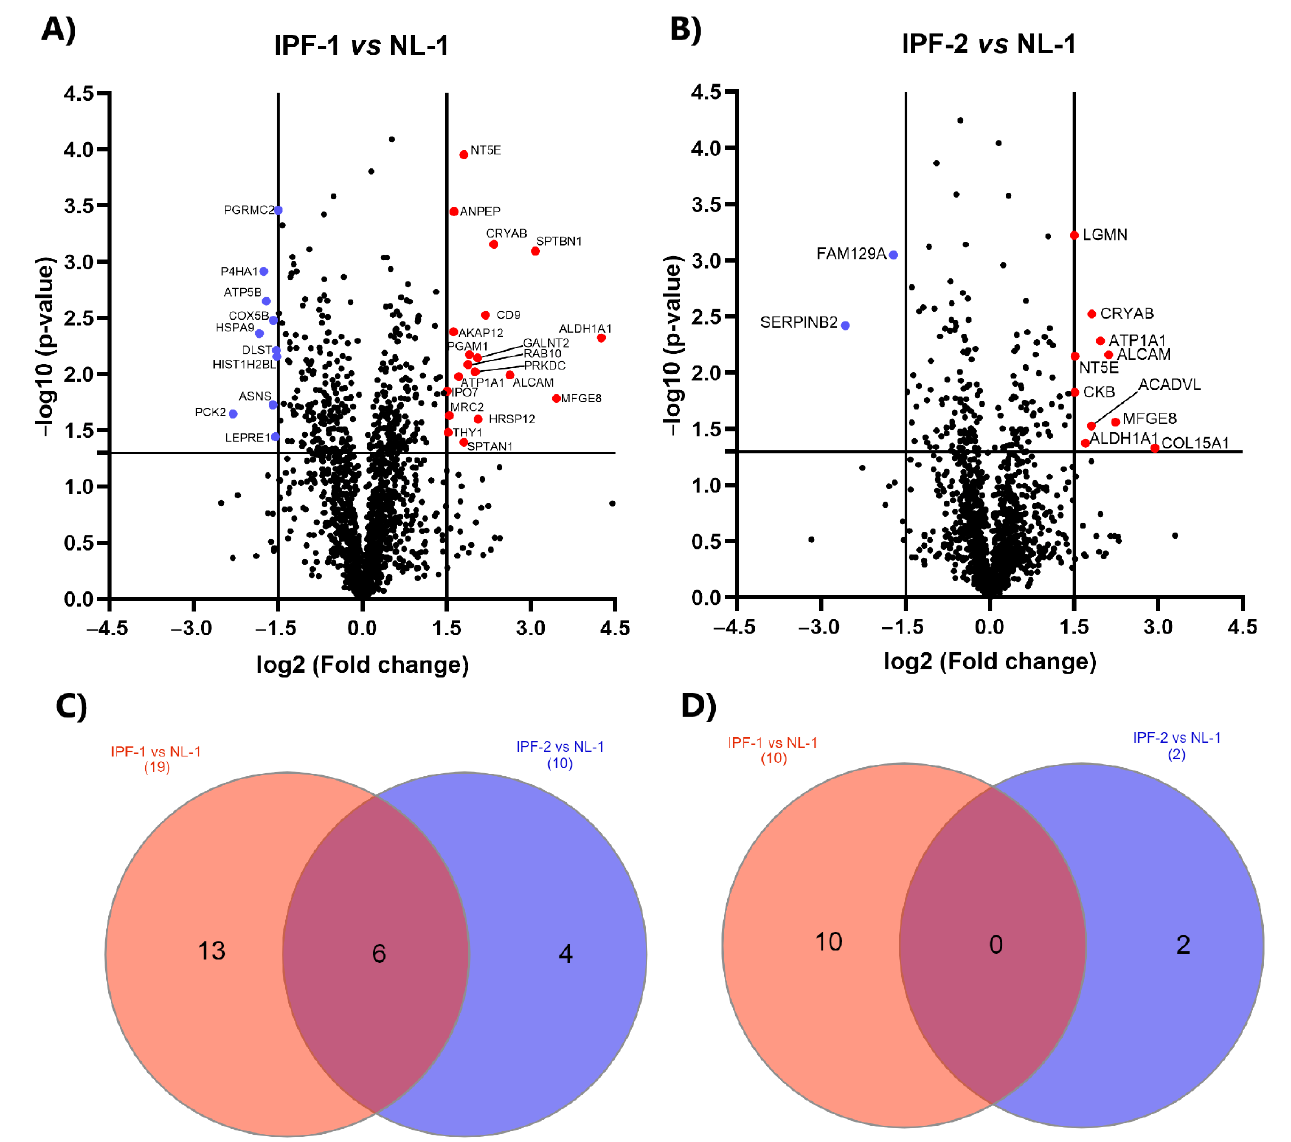
Figure 4. Differentially expressed proteins. ( A , B ) Volcano plot showing both up-regulated (red) and down-regulated (blue) proteins in all pairwise comparisons. Volcano plots depict FC ( x -axis) and − log10 value of p -value ( y -axis). Red dots in the upper right (ratio ≥ 1.5) and blue dots in the upper left (ratio ≤ 1.5) sections represent significantly deregulated proteins, p < 0.05. ( C ) Venn diagram showing the distribution of up-regulated proteins in the comparison groups. ( D ) Venn diagram showing the distribution of down-regulated proteins in the comparison groups. IPF, idiopathic pulmonary fibrosis; NL, normal lung.